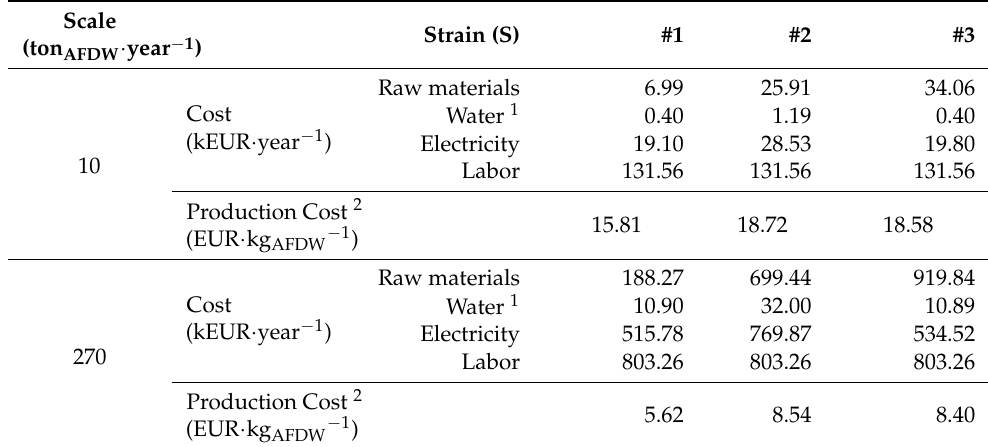
Table 4. S#1, S#2, and S#3 yearly operating costs according to Scenario 4 (water recirculation and use of flue gas) for both assessed scales, 2019